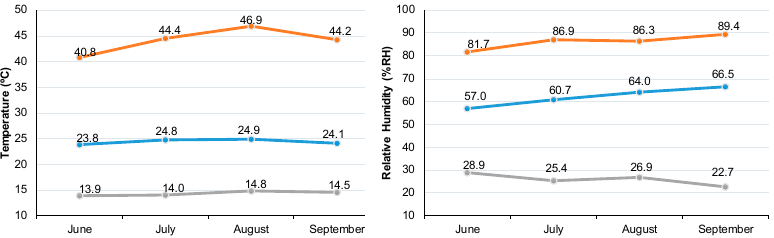
Figure 1. Monthly average values (blue), maximum (orange) and minimum (gray) temperature and relative humidity observed in the greenhouse during the test period.